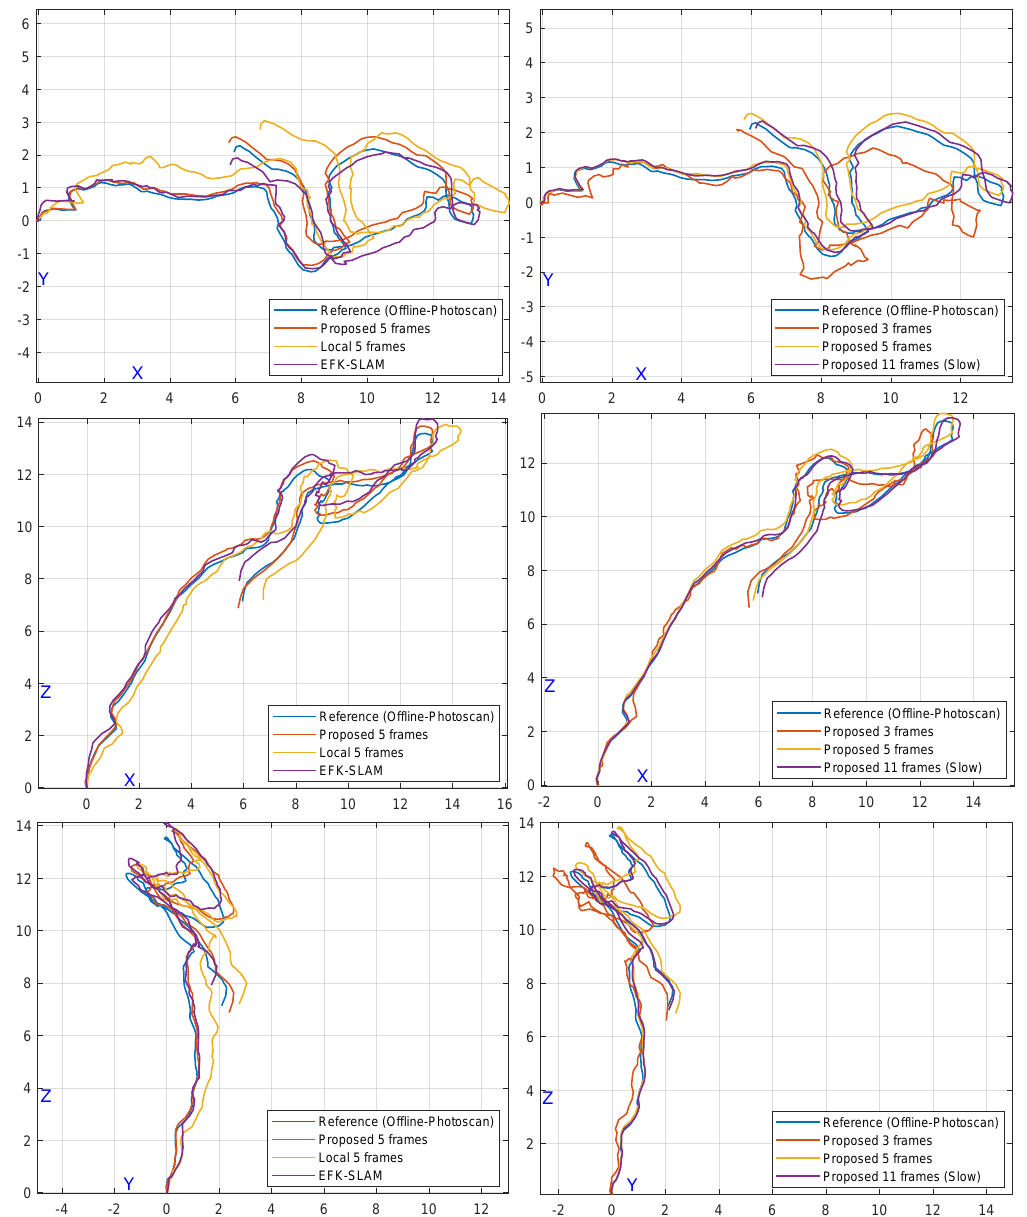
Figure 15. Comparison of trajectory estimation using several methods and parameters. The trajectory obtained using Agisoft Photoscan was considered a reference. It was compared to our method, local optimization using 5 frames, and EFK-SLAM [50] ( left column ). It was also compared to our method in cases where 3, 5, or 11 frames were used for optimization ( right column ). All units are in